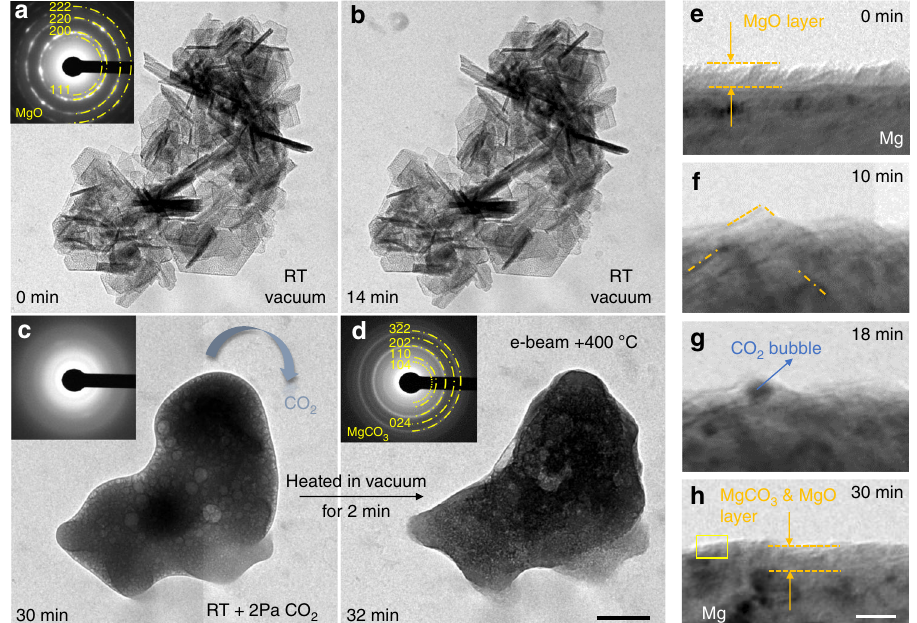
Fig. 2 Validation of the proposed operation principle. a TEM image of the MgO crystal fl akers synthesized by hydrothermal method. b The MgO fl akers did not change after being exposed to a 300 keV, 0.1 A/cm 2 e-beam irradiation for 14 min. c The introduction of 2 Pa CO 2 atmosphere leads the reaction, i.e. MgO + CO 2 → MgCO 3 , occurred violently. The fi nal product is that the MgO fl akers were transformed into a piece of amorphous product with many bubbles in it. d After being heated to 400 °C in vacuum for 2 min, the amorphous product was crystallized. The inset selected area electron diffraction (SAED) pattern shows that it is nanocrystalline MgCO 3 . e – h Surface evolution of a FIB-fabricated Mg pillar during the exposure in 2 Pa CO 2 and e-beam irradiation. TEM images showing transformation process of the native oxide layer to the compact nanocrystalline MgCO 3 &MgO layer. Scale bars: d 200nm, h 10 nm